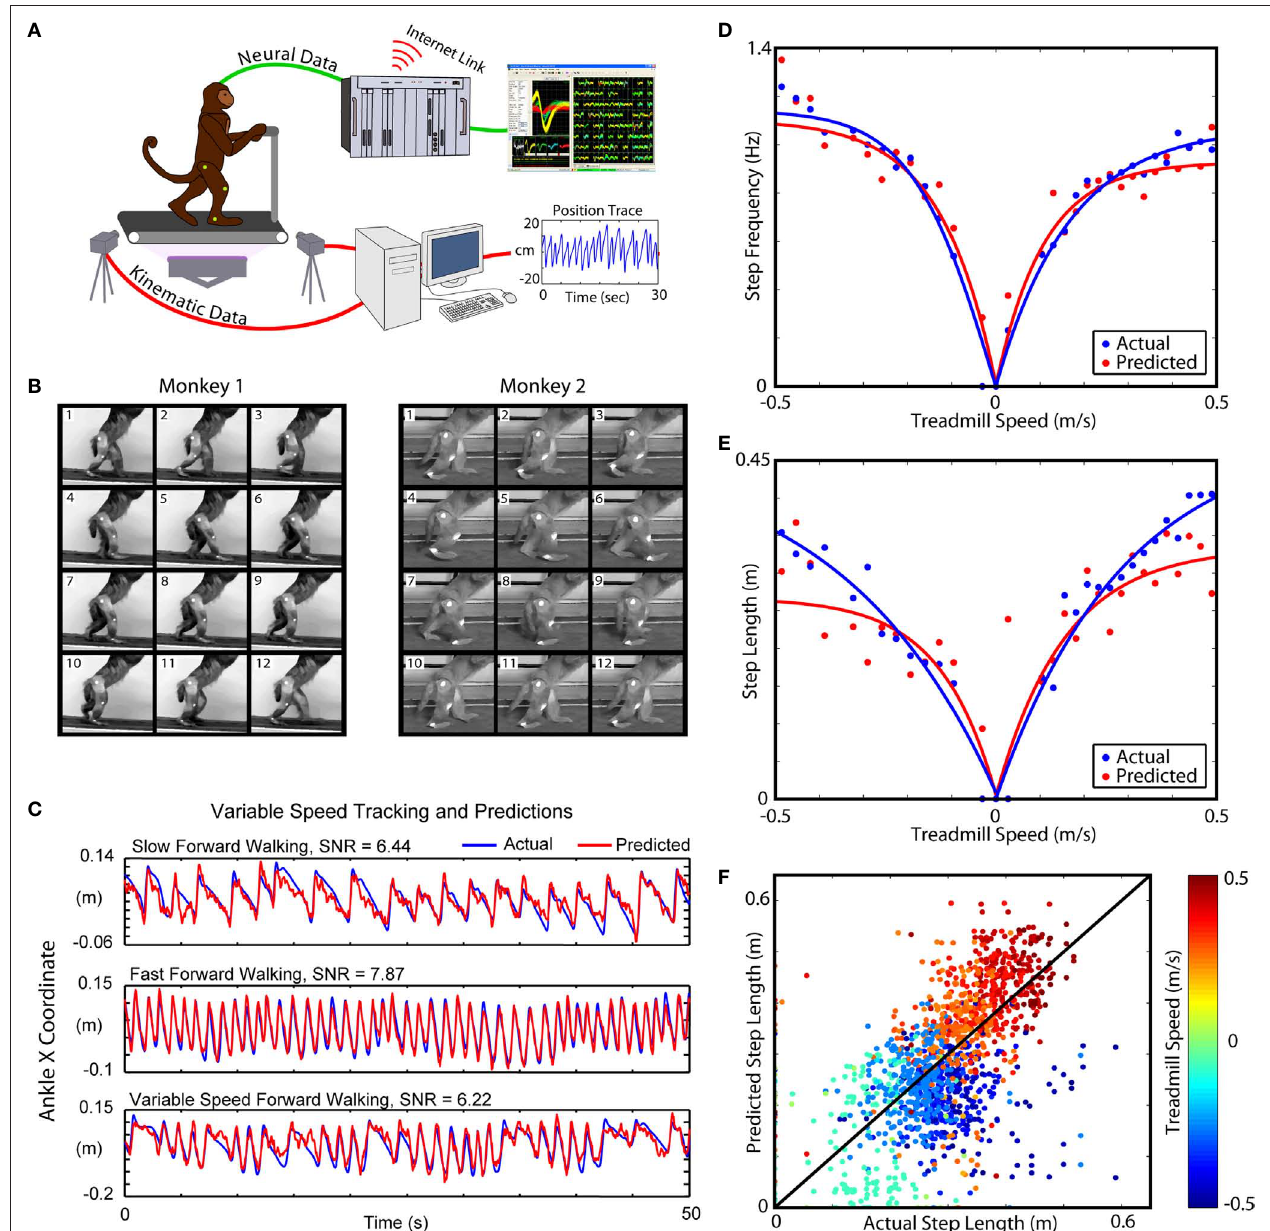
an average over an epoch of constant treadmill speed during variable speed and direction sessions. (E) The relationship between step length and walking speed. As in (C) , blue and red correspond to the actual and predicted values, respectively. (F) Actual step lengths versus extracted step lengths during all variable speed sessions. Blue dots represent backward walking while red/ orange dots represent forward (see key on the right). Dots are clustered around the y = x line, indicating a match between the actual and predicted